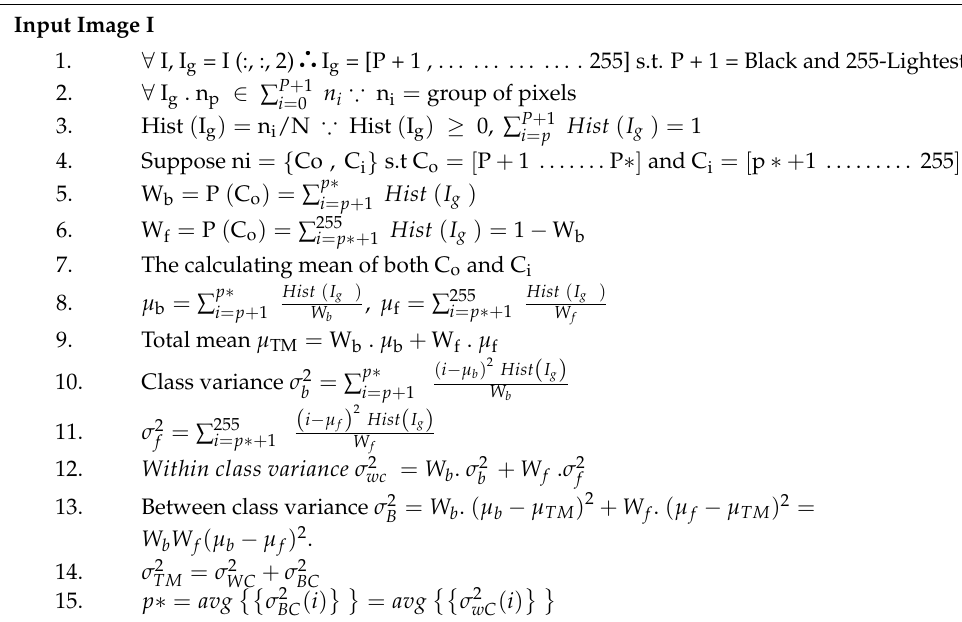
Algorithm 5: Algorithm of OTSU Thresholding Algorithm 5 : Algorithm of OTSU